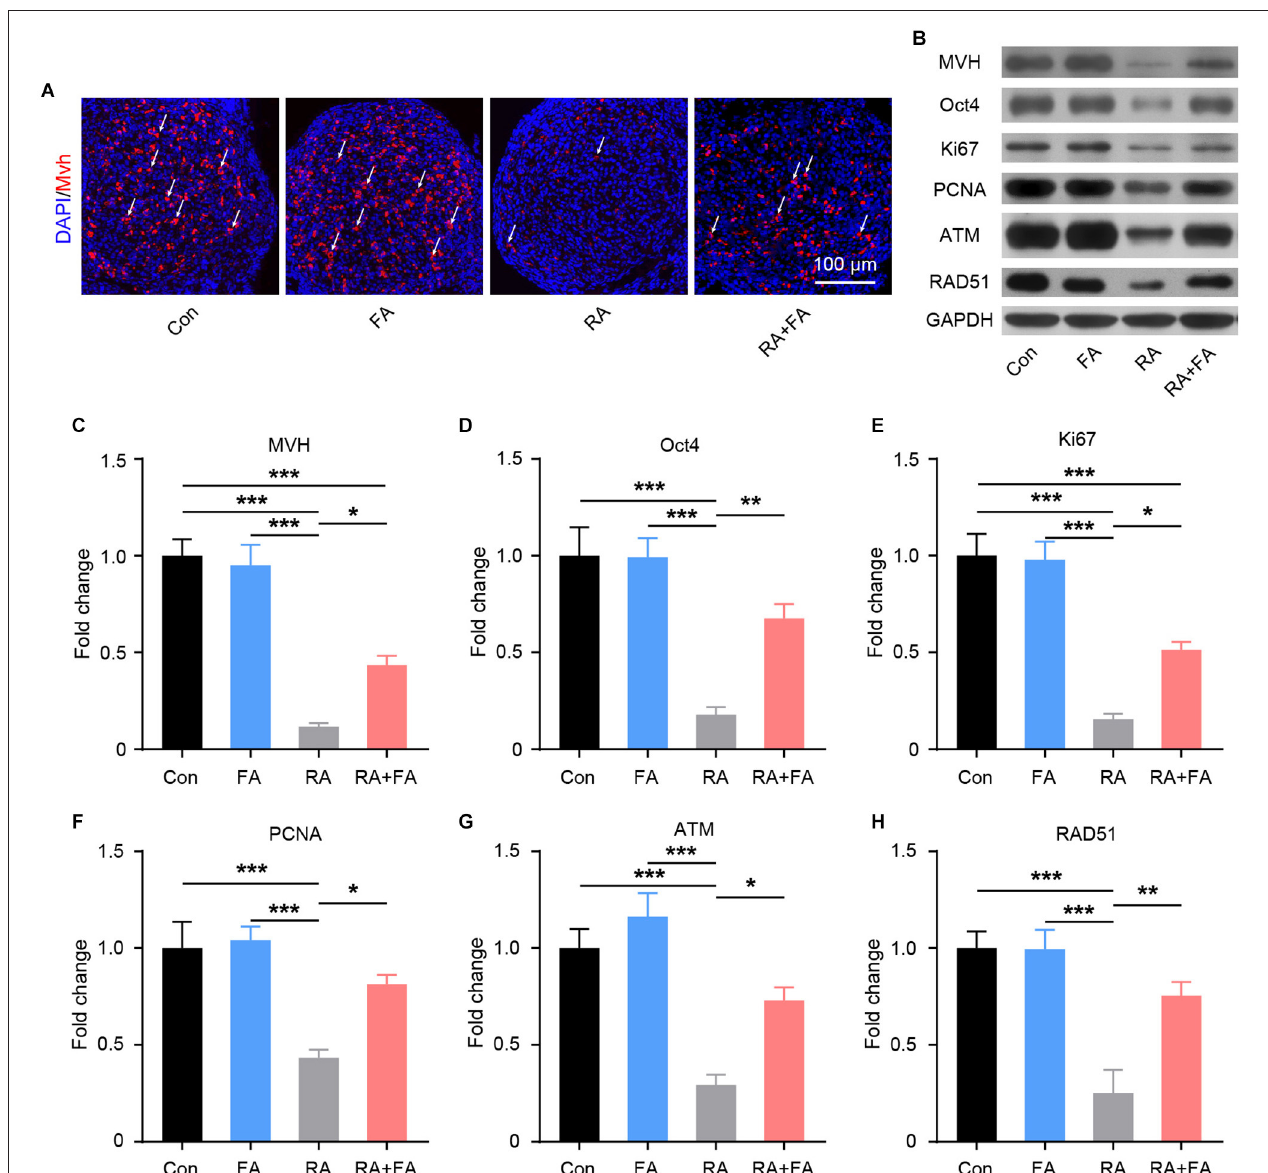
FIGURE 5 | Folic acid (FA) pre-administration reverses the radiation-induced suppression of reproductive ability in female mice. (A) MVH-positive ovarian germ cells were observed via immunofluorescence analysis of ovarian tissue. Germ cells are stained in red, and nuclei are stained in blue (DAPI). Scale bar, 100 µ m. (B) Western blot was performed to detect the protein levels of MVH, Oct4, Ki67, PCNA, ATM, and RAD51 in ovarian tissues from each group. MVH, mouse vasa homolog; PCNA, proliferating cell nuclear antigen; ATM, ataxia-telangiectasia mutated. (C–H) Immunoblot semi-quantitative analysis of MVH, Oct4, Ki67, PCNA, ATM, and RAD51 in ovarian tissues of each group. Error bars, standard error of mean (SEM). N = 8, * p < 0.05, ** p < 0.01, and *** p < 0.001.